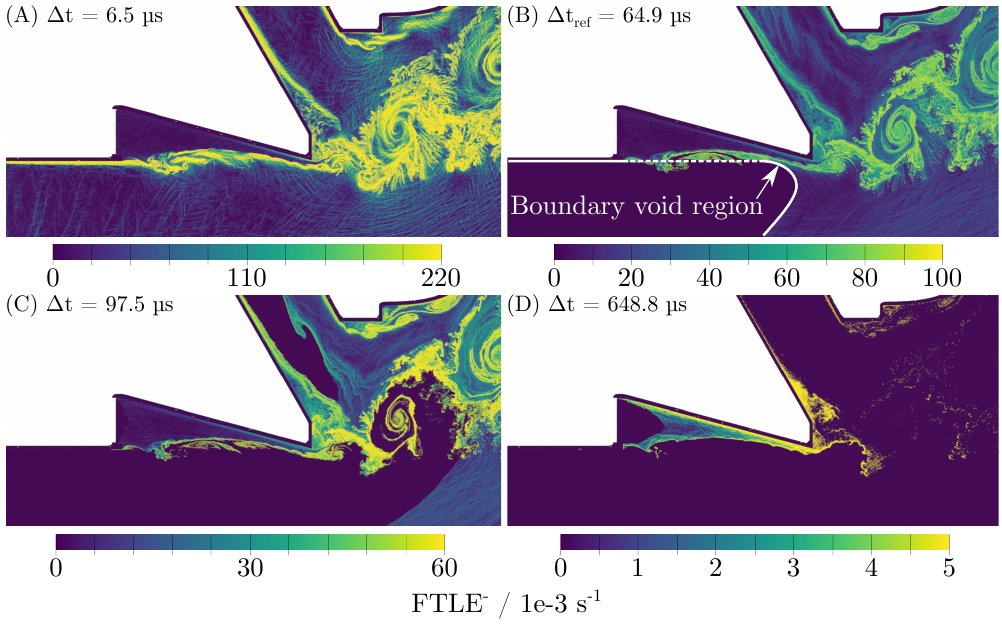
Figure 7. Fields of the FTLE − for different values of ∆ t